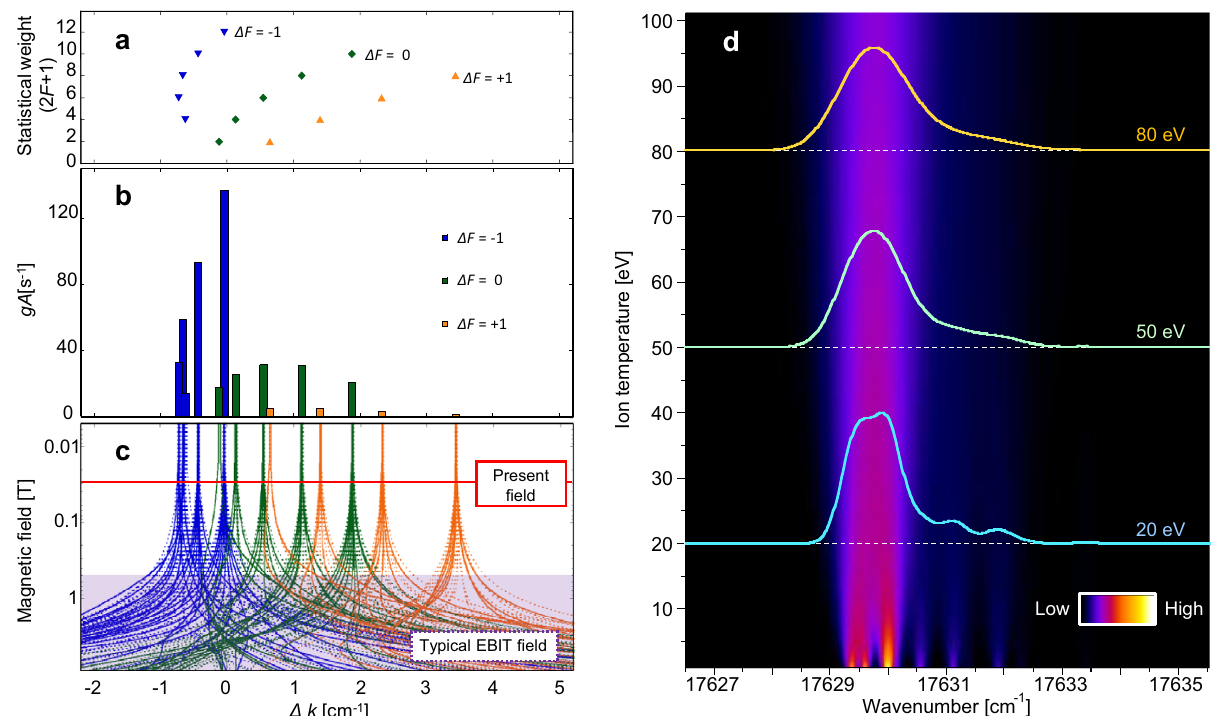
5 s ) J = 3 . b Spectral 5 = 2